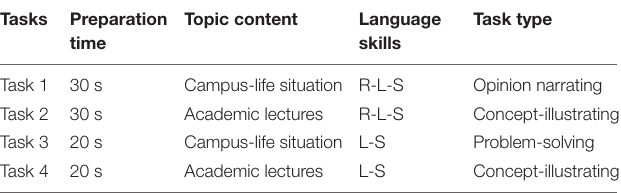
TABLE 1 | Variability in task demands in the four integrated speaking test